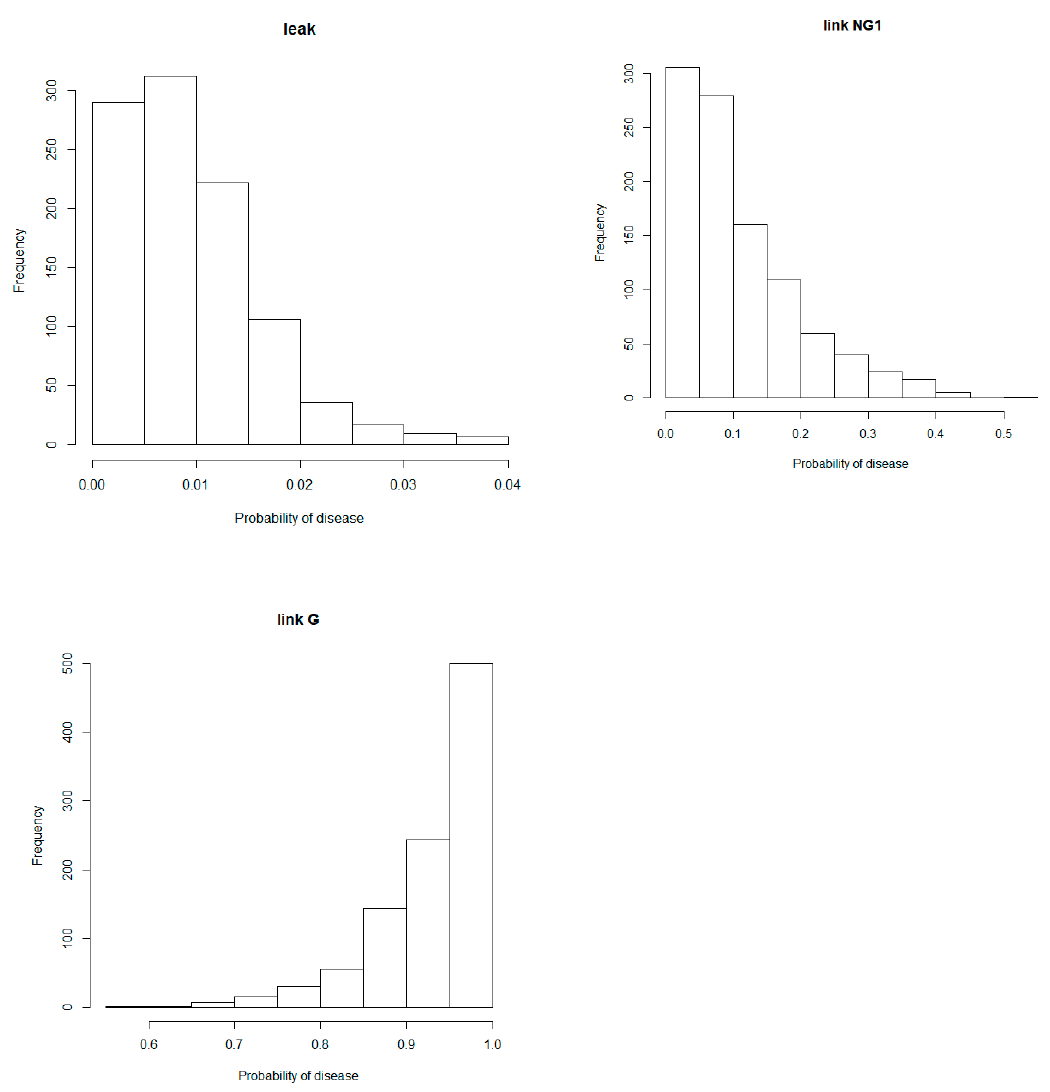
Figure 2. Beta distributions when the mean is set at 1% (leak), 10% (link NG1) and 90% (link G).